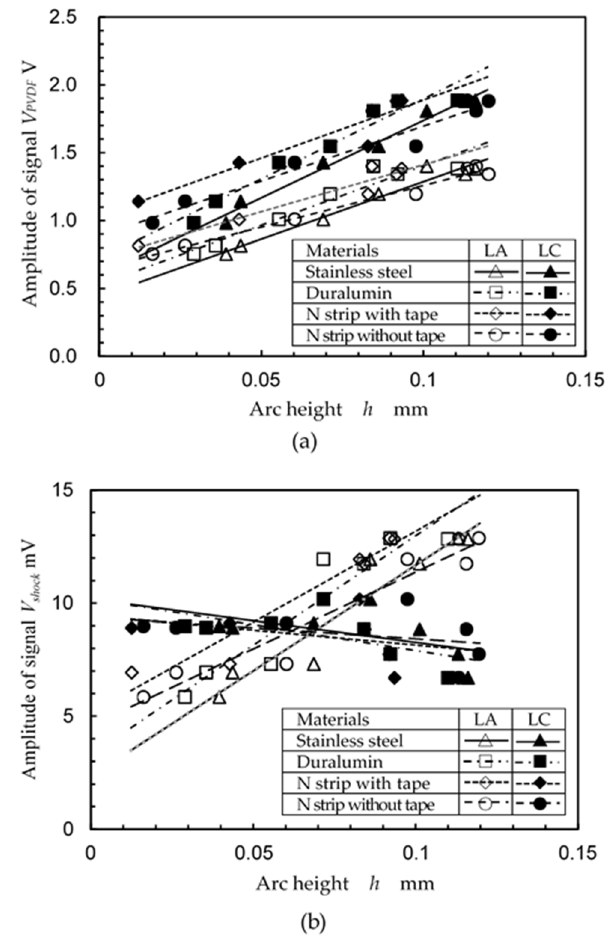
Figure 6. Relationship between the arc height and amplitude of the output signal from sensors. ( a ) PVDF sensor; ( b ) submerged shockwave sensor. Table 1. Correlation coefficient between the arc height and output signal from the sensors.